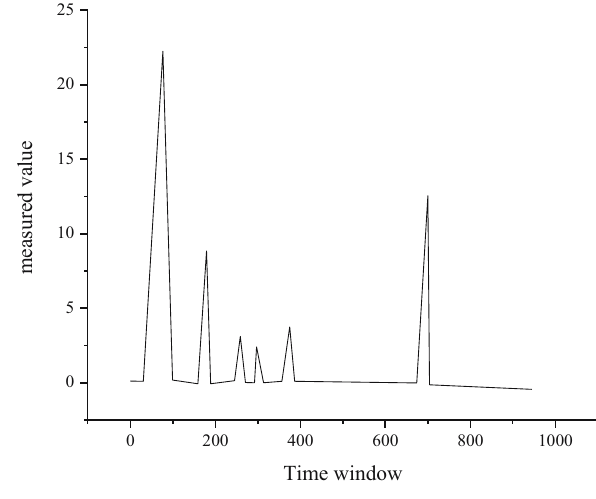
Figure 3: Change graph of original data attack